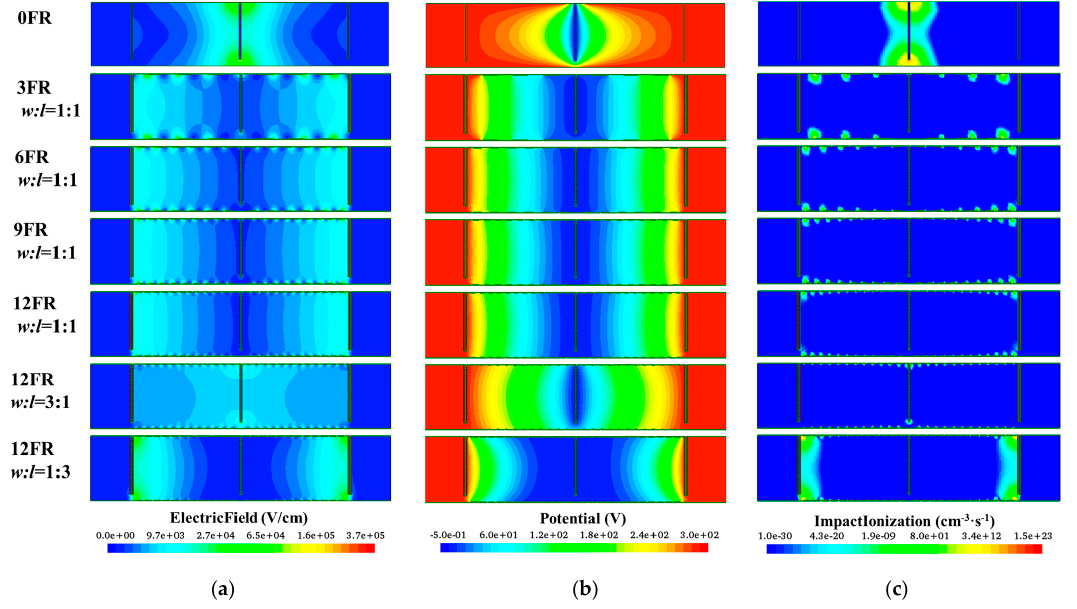
Figure 4. The 3D large-area detectors with different numbers of floating rings and different ratios of ring width and ring spacing with an applied reverse bias voltage of 300 V: ( a ) Electric field distribution; ( b ) Potential distribution; ( c ) Impact ionization distribution. Table 1. Device simulation results of breakdown voltage with different numbers and ratios of float- ing rings in N+P − P+ structure.